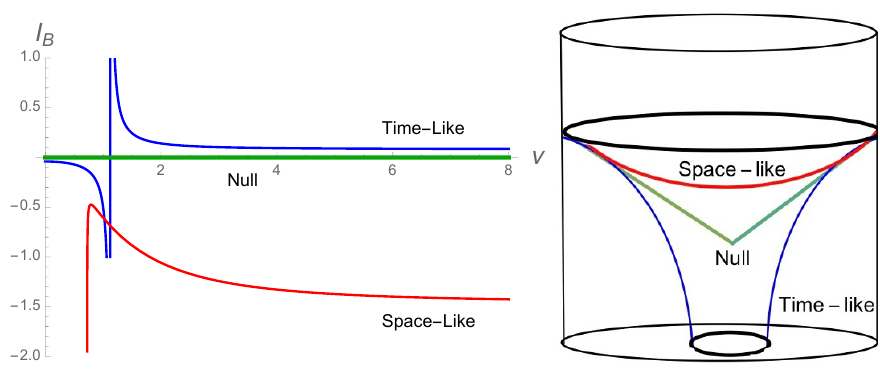
Figure 2 . In the left part, the di(cid:11)erentiating, boundary term in the chiral Liouville action versus deforming parameter (cid:23) for the case of time-like and space-like warped AdS 3 is shown. The right part is similar to (cid:12)gure 3 of [30] which is for the case of AdS. The warped AdS would have deformed constructions depending on the value of (cid:23) . These plots show the respective relations between these three